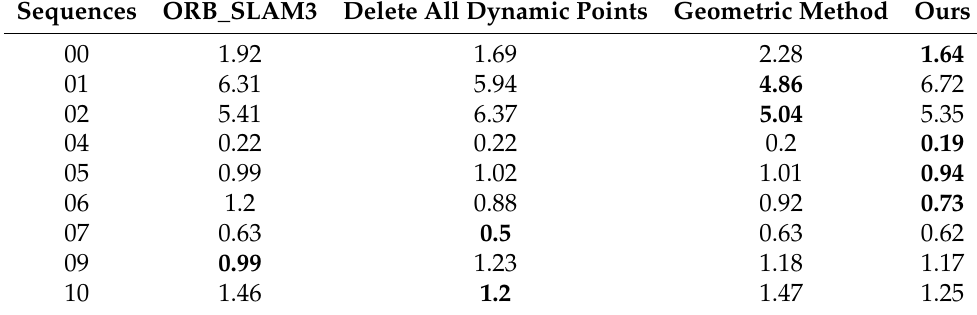
Table 6. Absolute trajectory error of the original algorithm, the algorithm of removing all feature points falling in the bounding box, the geometric method using RANSAC, and the improvement algorithm(with Sim(3) Umeyama alignment), while processing panning rotation and